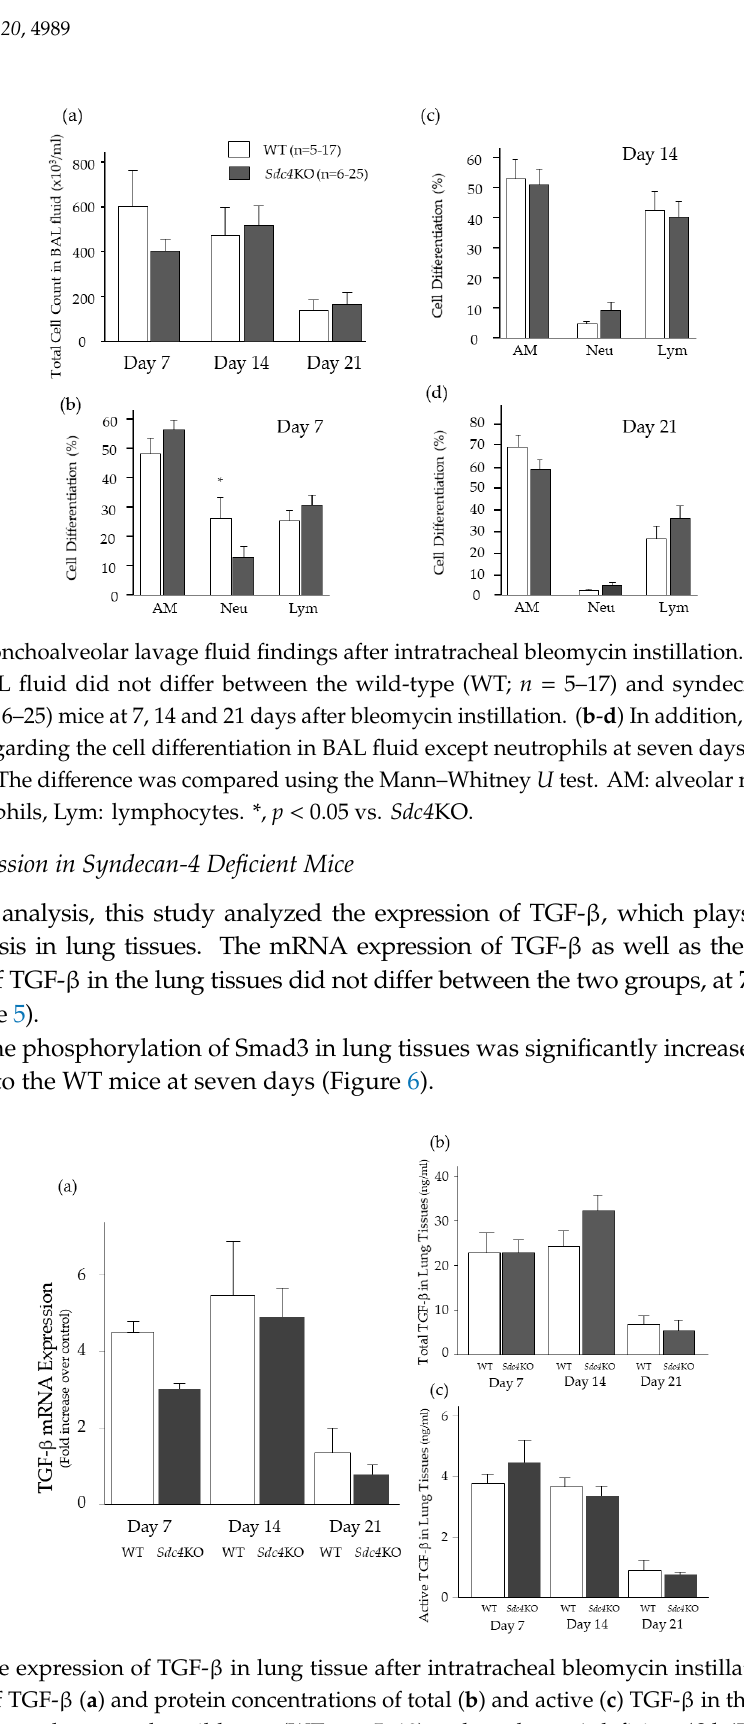
Figure 6. Levels of phosphorylated Smad3 in lung tissues. Levels of phosphorylated Smad3 in lung tissues were higher in the syndecan-4-deficient ( Sdc4 KO) mice compared to the wild-type (WT) mice at 7 days after intratracheal bleomycin instillation. The difference were compared using the Mann- Whitney U test as well as the ANOVA test with Fisher ’ s least significant difference test as a post hoc test. *, p < 0.05 vs. WT at 7 days after bleomycin instillation , †, p < 0.05 vs. WT and Sdc4 KO without bleomycin instillation, ‡, p < 0.05 versus WT and Sdc4 KO at 21 days after bleomycin instillation ( n = 3 – 7/each group).